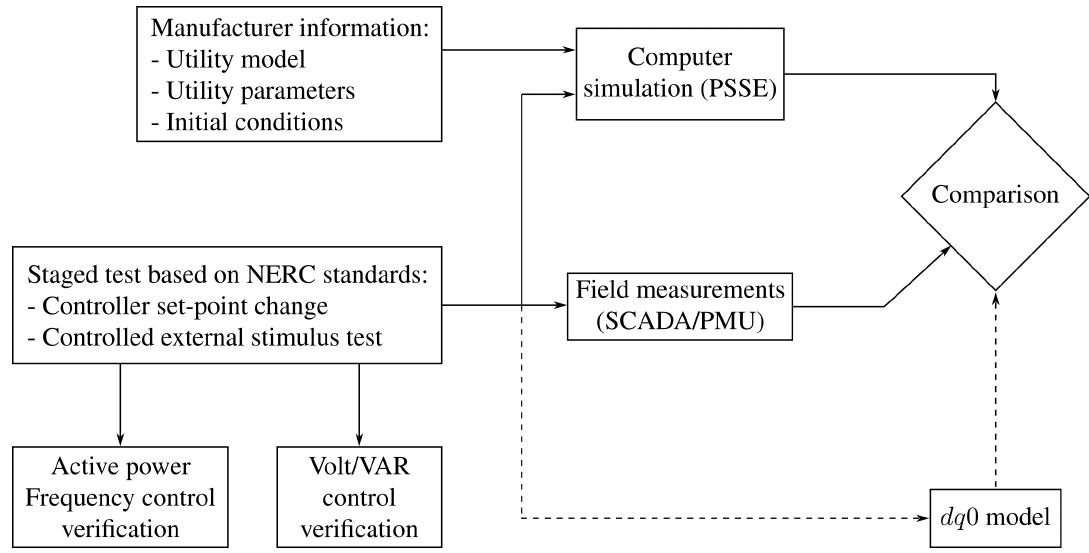
Figure 8. Flowchart of the validation